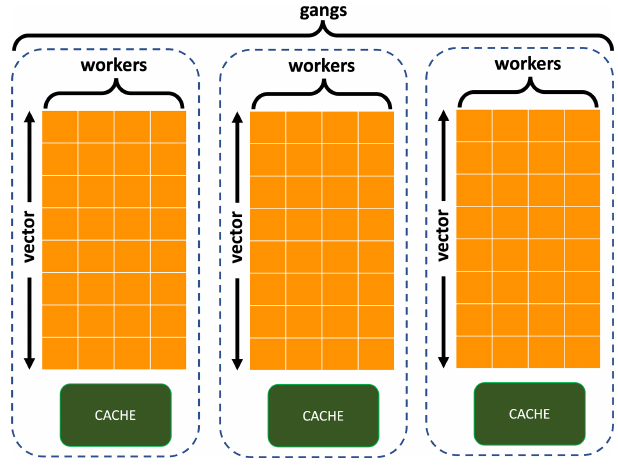
Figure 2. A map of gangs, workers, and vectors (adapted from Jiang et al.,